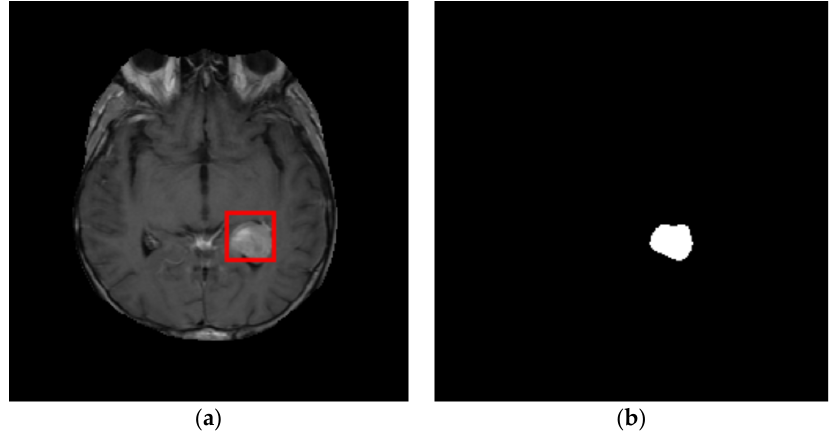
Figure 11. ROI segmentation using K ‐ means: ( a ) identified ROI; ( b ) ROI segmented with K ‐ means.